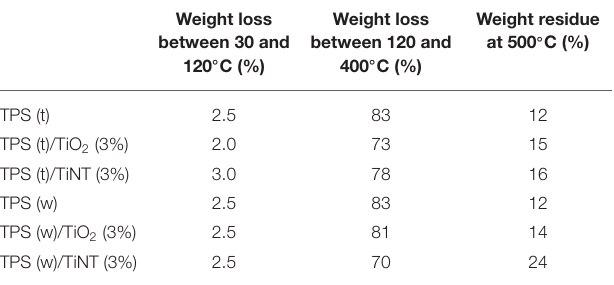
TABLE 2 | TGA Results: Weight losses and weight residue (wt.%) of starch samples during thermal degradation under nitrogen atmosphere and heating rate 10 ◦